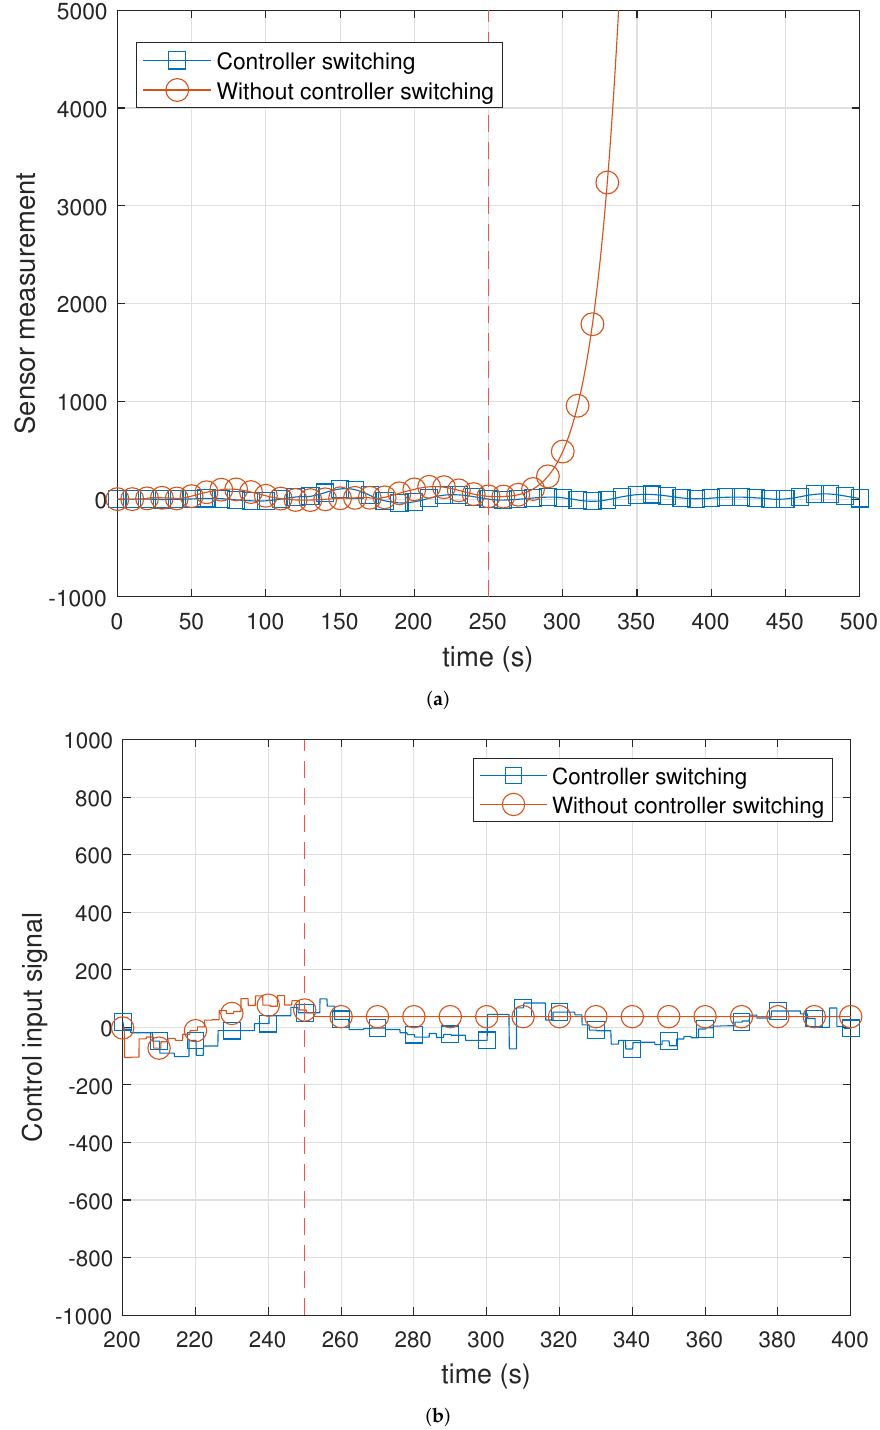
Figure 10. Experimental results on plant with/without controller switching mechanism. ( a ) Sensor measurements; ( b ) control input